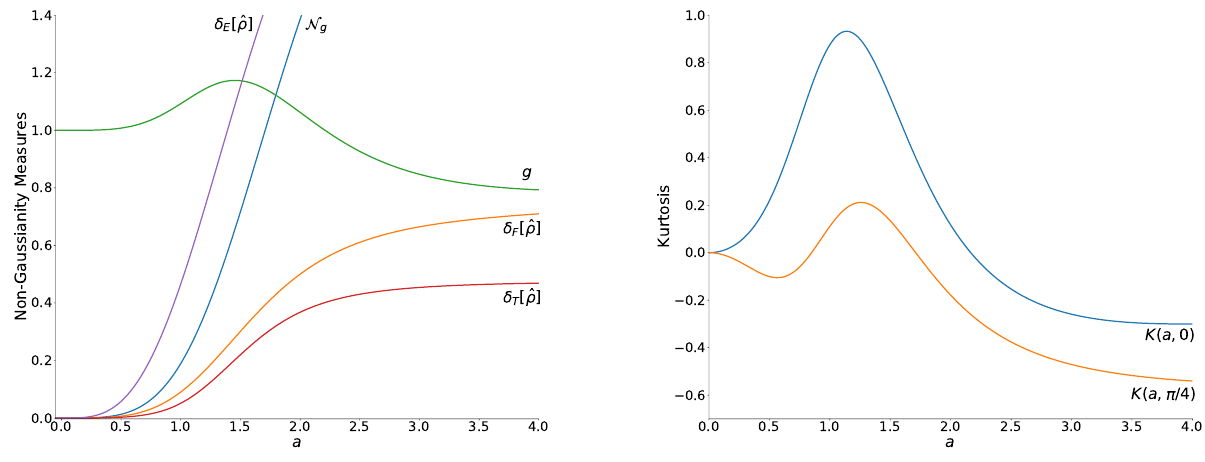
Figure 8. The behavior of the non-Gaussianity measures ( left ) and kurtosis ( right ) as functions of parameter a for the Orthogonal Even Coherent